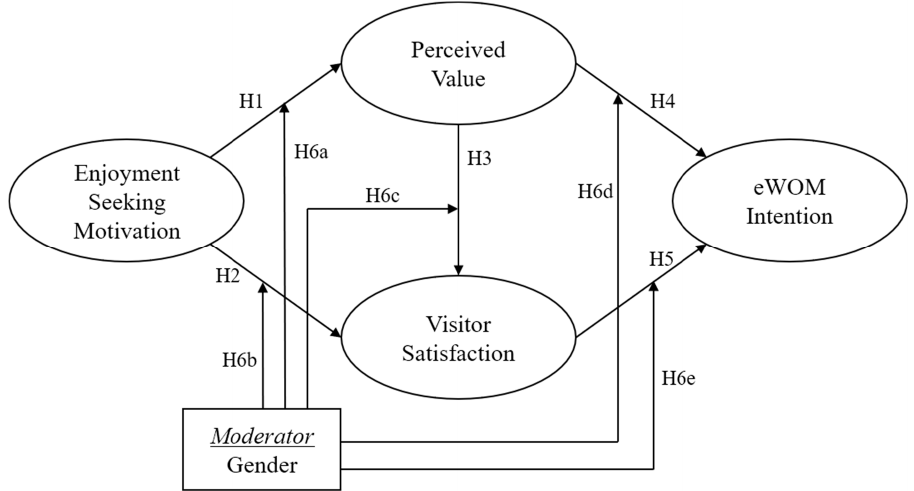
Figure 1. Proposed structural